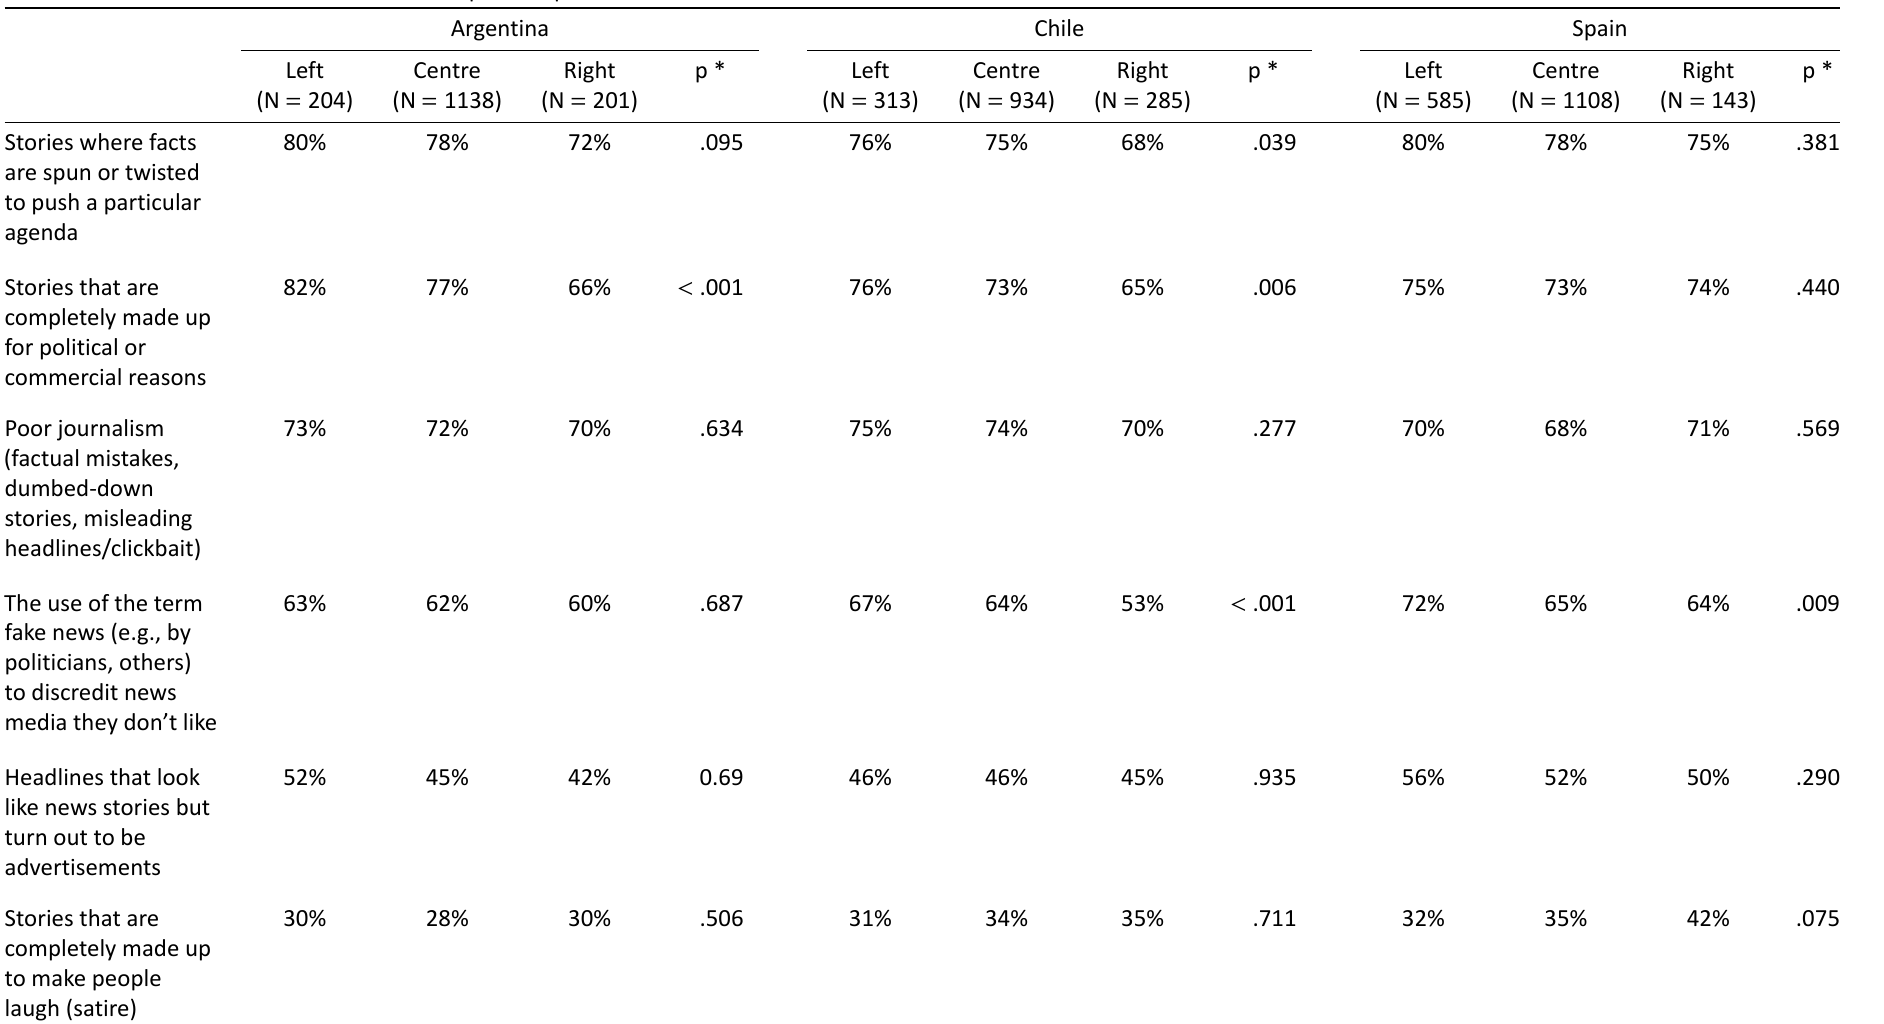
Table 4. Concern about disinformation due to political position. Argentina